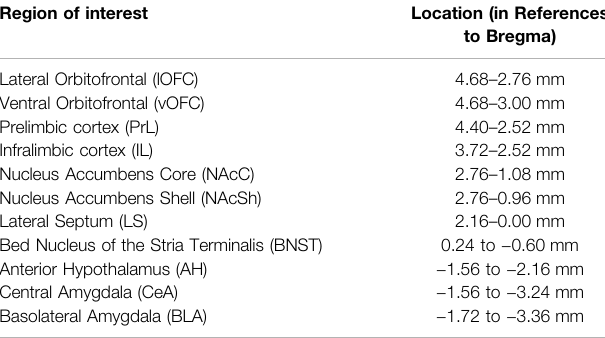
TABLE 1 | Anatomic location of each region of